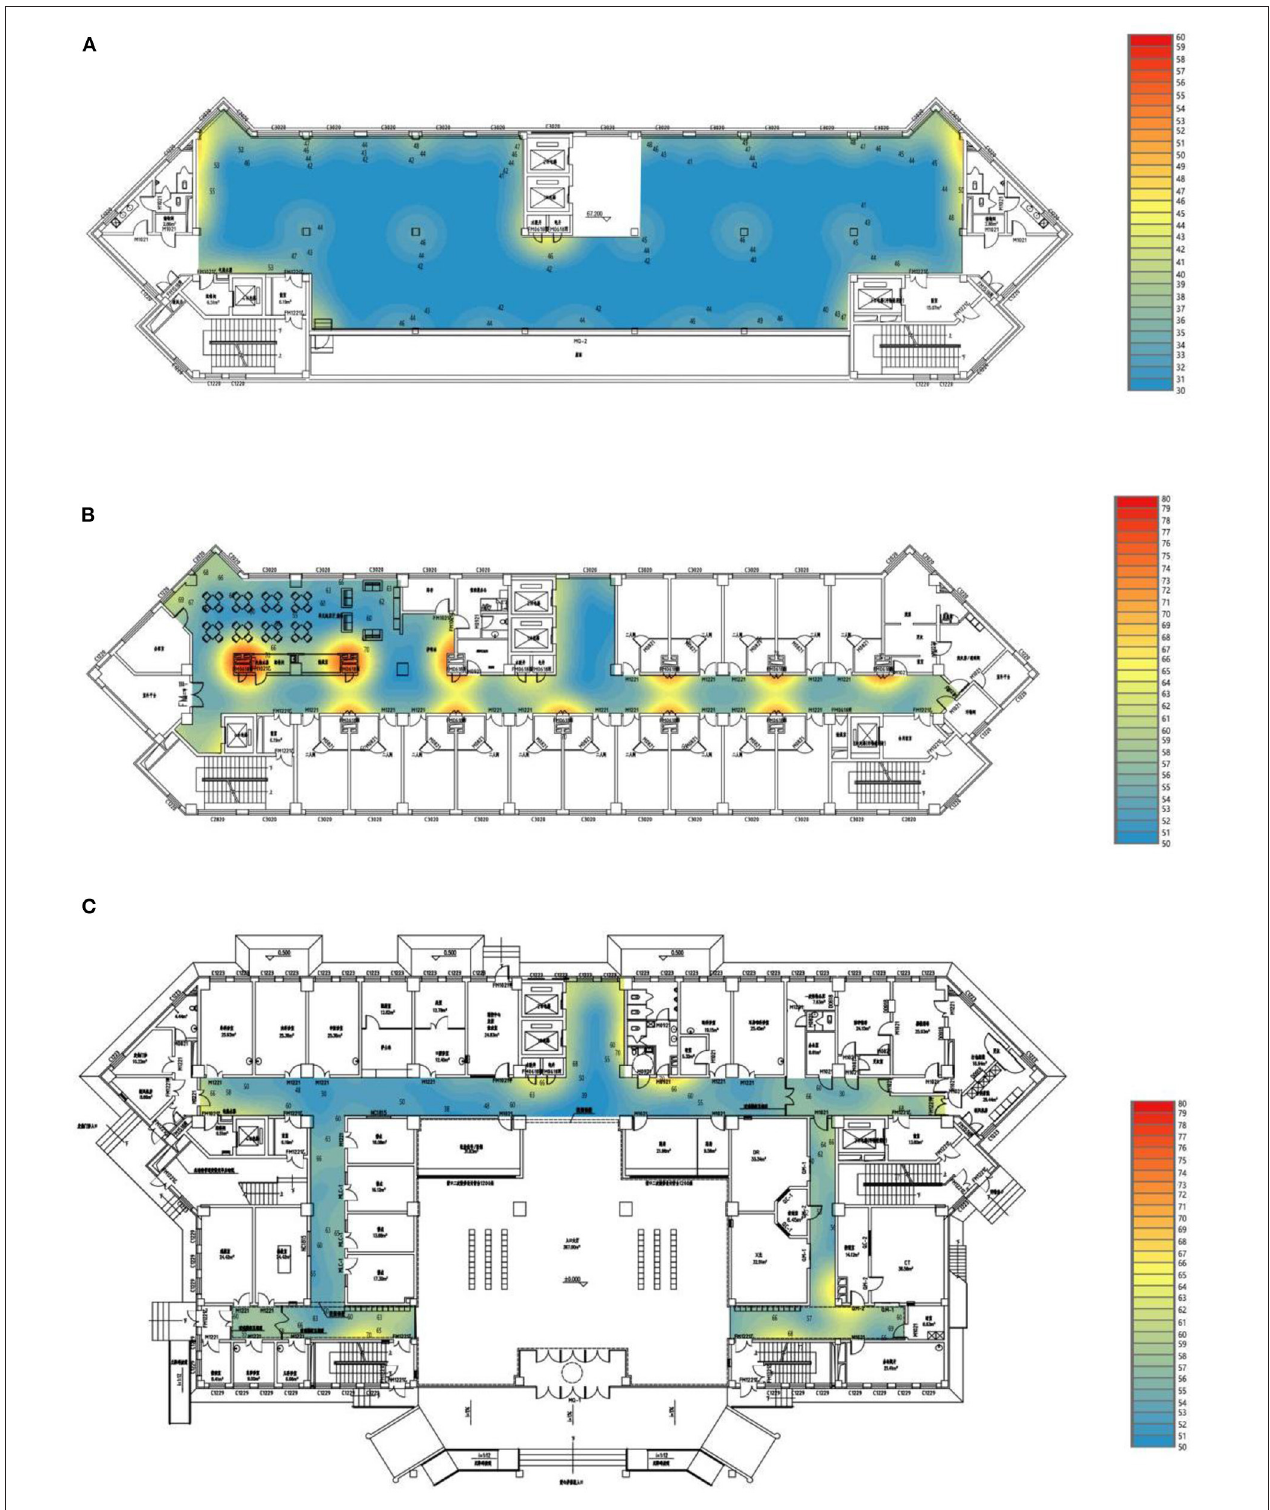
FIGURE 3 | SPL distribution of different space (A) sunshine hall (B) living room (C) corridor of the health care center.